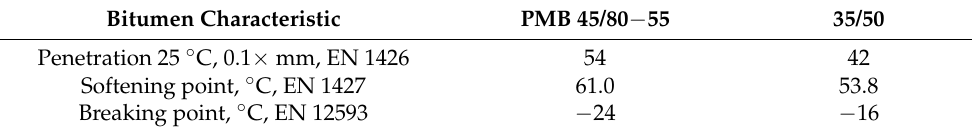
Table A5. Basic bitumen